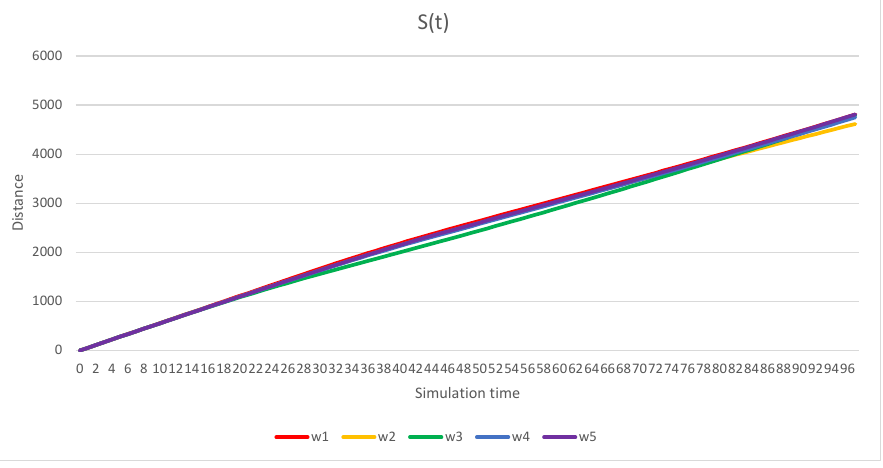
Figure 8. Change in distance traveled S ( t ) in simulation by context 1 for distance D 0 = D gr = 2000 m. For context 2: